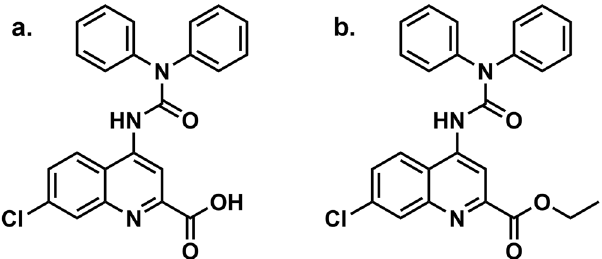
Figure 1. Chemical structure of DCUK compounds. ( a ) DCUKA (5,7-Dichloro-4-([diphenyl carbamoyl] amino) quinoline-2-carboxylic acid). ( b ) DCUK-OEt (5,7-Dichloro-4-([diphenyl carbamoyl] amino) quinoline-2-ethyl